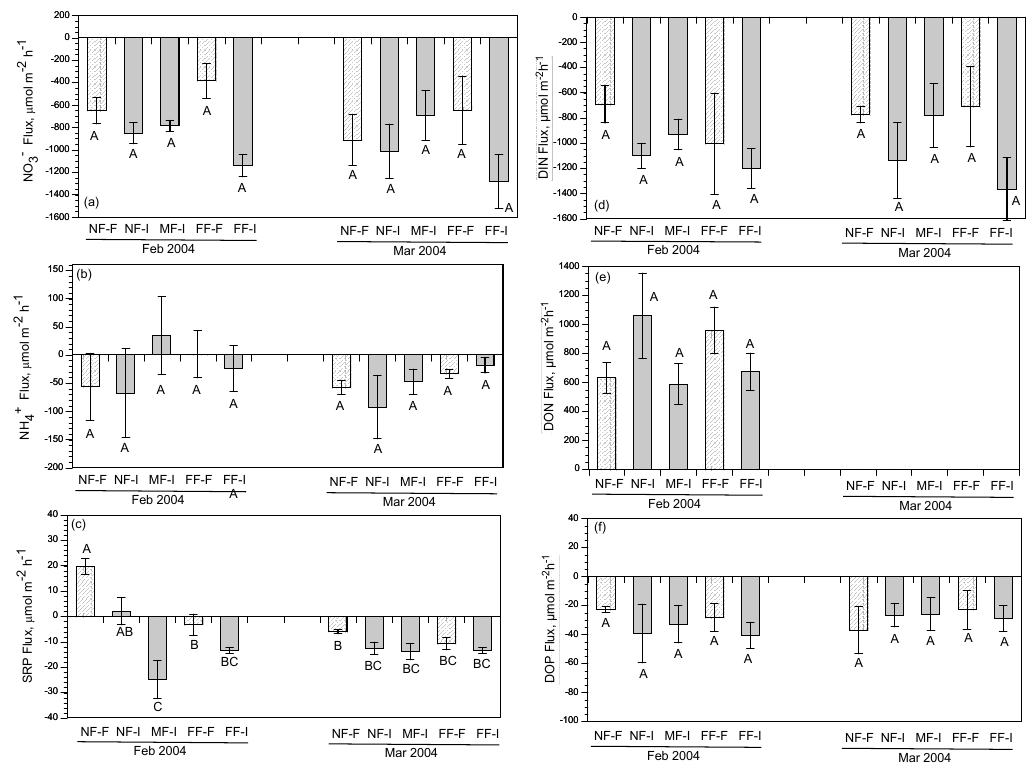
Figure 7. Intertidal benthic fluxes of ( a ) NO 3 − , ( b ) NH 4 + and ( c ) SRP, ( d ) DIN, ( e ) DON, and ( f ) DOP during the February and March pulse experiments (2004) at five locations based on distance from diversion structure (NF-F = near-field fringe, NF-I = near-field interior, MF-I = mid-field interior, FF-F = far-field fringe, and FF-I = far-field interior.). Bars with diagonal lines are fringe and gray shade are interior. Bars with same letter are not significantly different based on Tukey least squares analysis.